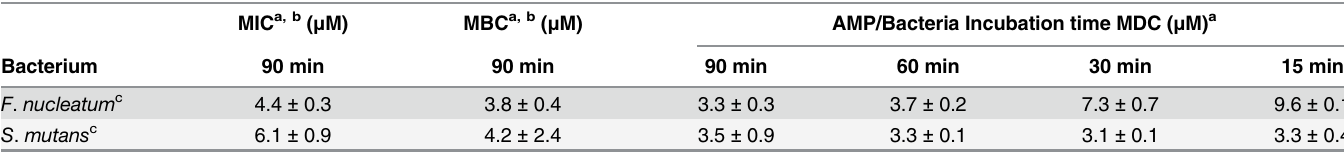
Table 1. MIC and MBC of melittin for F . nucleatum and S . mutans and comparison with the membrane disrupting concentration (MDC) determined at different peptide/bacteria incubation